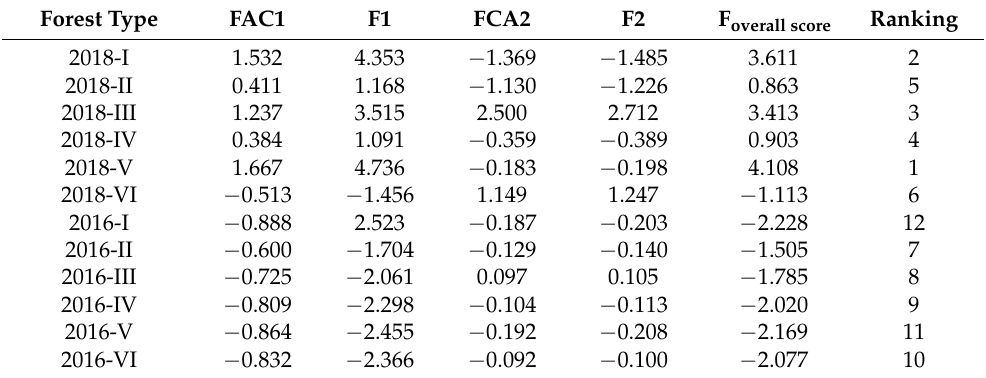
Table 5. Score and overall score of principal components influencing each index of soil fertility.